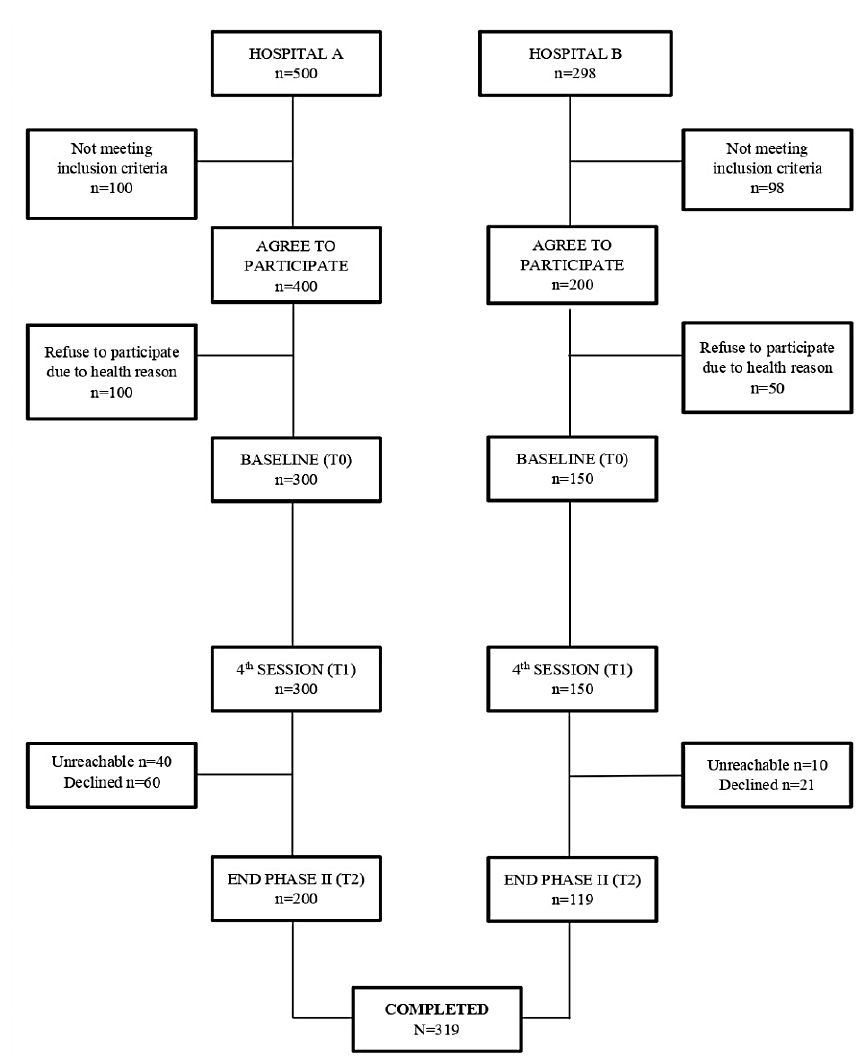
Figure 1. Study Flow Diagram